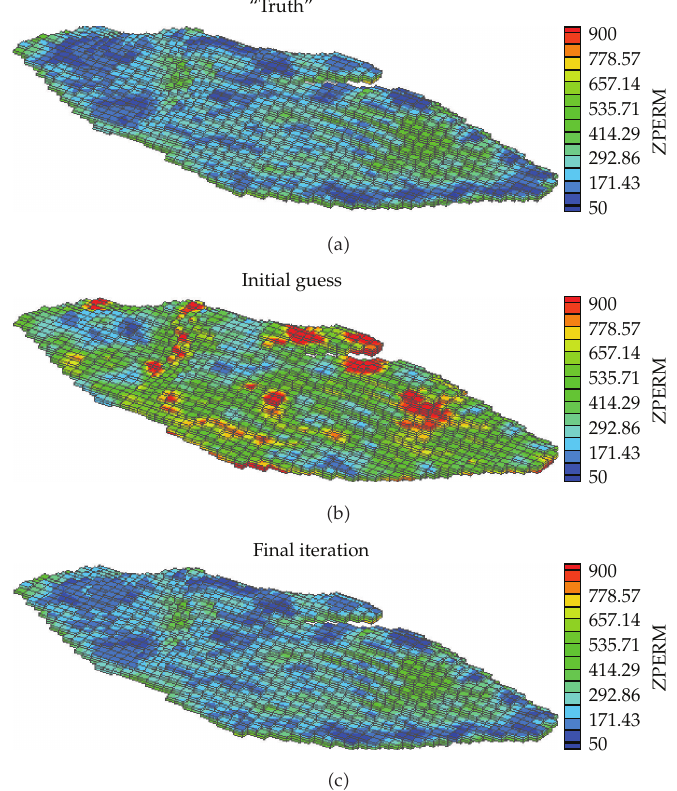
Figure 10: Example 2 (cid:6) Brugge field test (cid:7) : estimate of permeability with SPSA iteration